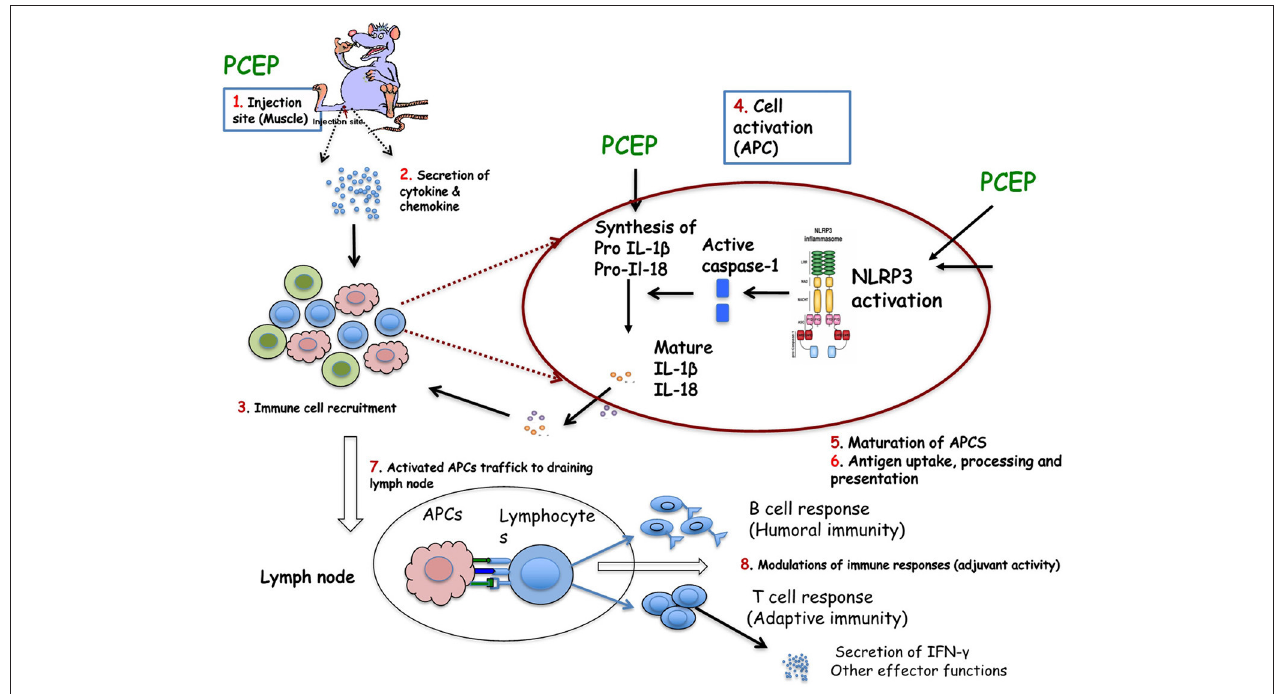
FIGURE 2 | Proposed mechanism of action of PCEP: (1) PCEP injected into muscle is transiently retained locally, induces genes involved in innate immunity. (2) PCEP induces local cells to secret cytokines and chemokines. (3) The secreted cytokines and chemokines initiate recruitment of various immune cells, including APCs (such as DCs) to the injection site. The recruited cells are activated and secrete more cytokines and chemokines, which in turn chemoattracts other immune cells. All these events lead to formation of local immunocompetent environment at the injection site. (4) Recruited DCs (which express various PRRs both on the surface (TLRs, CLRs) and intracellularly (NLRs and RLRs) are recognized and/or activated by PCEP resulting in activation of inflammasome. It is not yet known whether PCEP modulates (5) Antigen uptake, process and presentation, or (6) maturation of APCs. (7) PCEP increases the trafficking of APCs to the draining lymph nodes to interact with antigen-specific B or T cell to (8) Resulting in potent antibody secreting B cells and/or effector CD8 + T cell responses. These events constitute adjuvant activity.